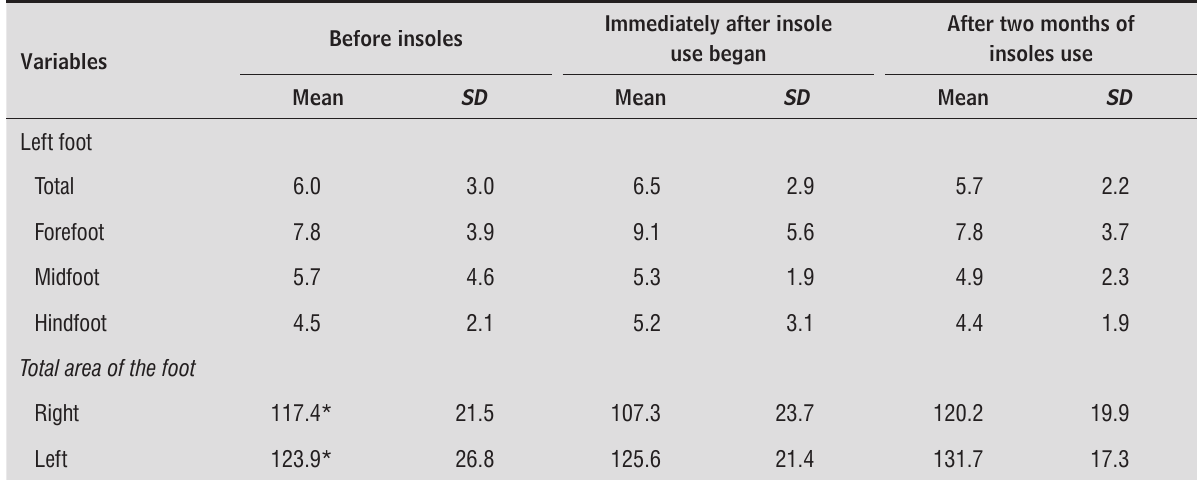
Total area of the